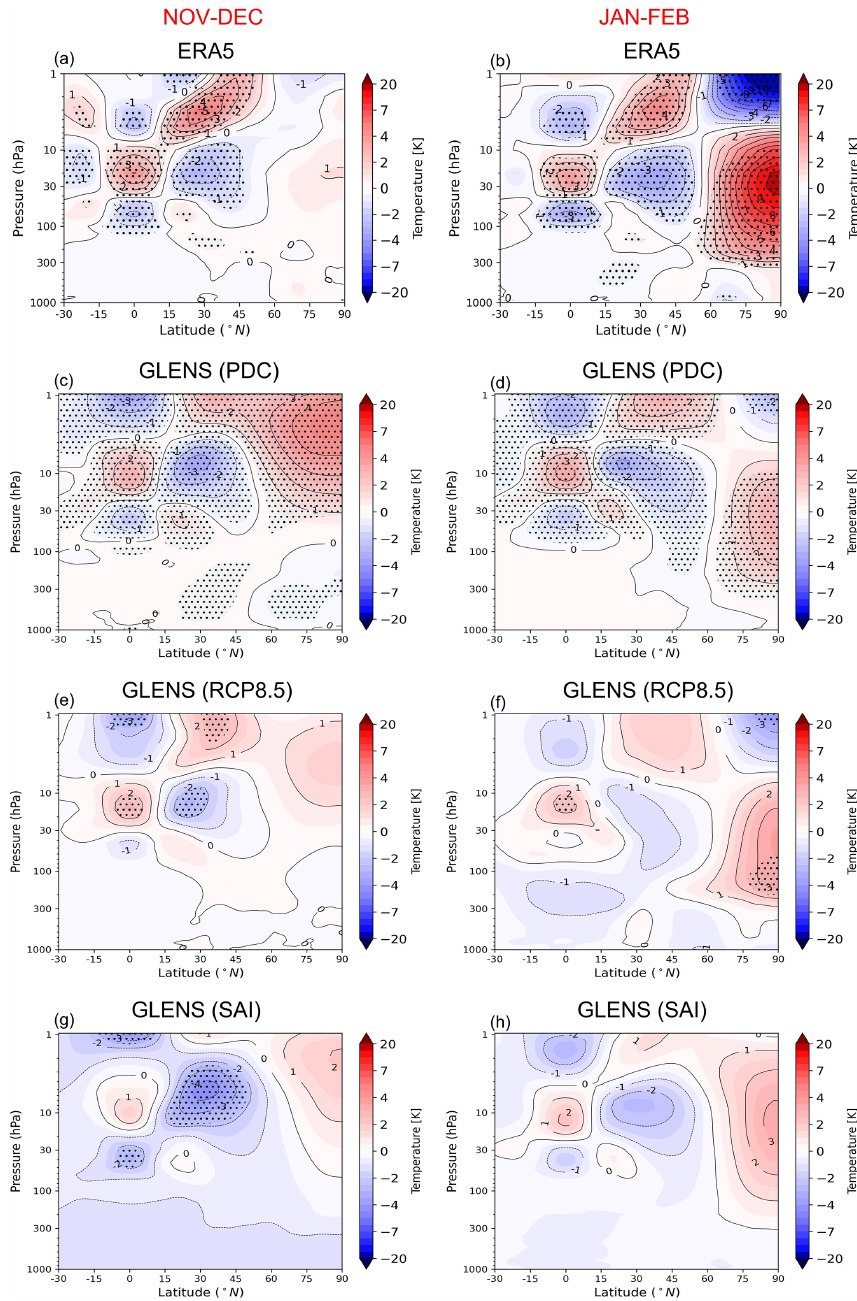
Figure 4. The same as Fig. 3 but for temperature. The stippled areas indicate regions where the changes are statistically significant at the 95% level according to the t